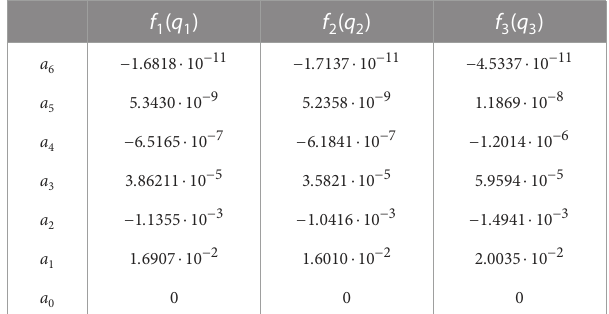
TABLE2 Polynomialfittingcoefficientsforthemapfrom q i to u i for single-chambercharacterizationcurves.